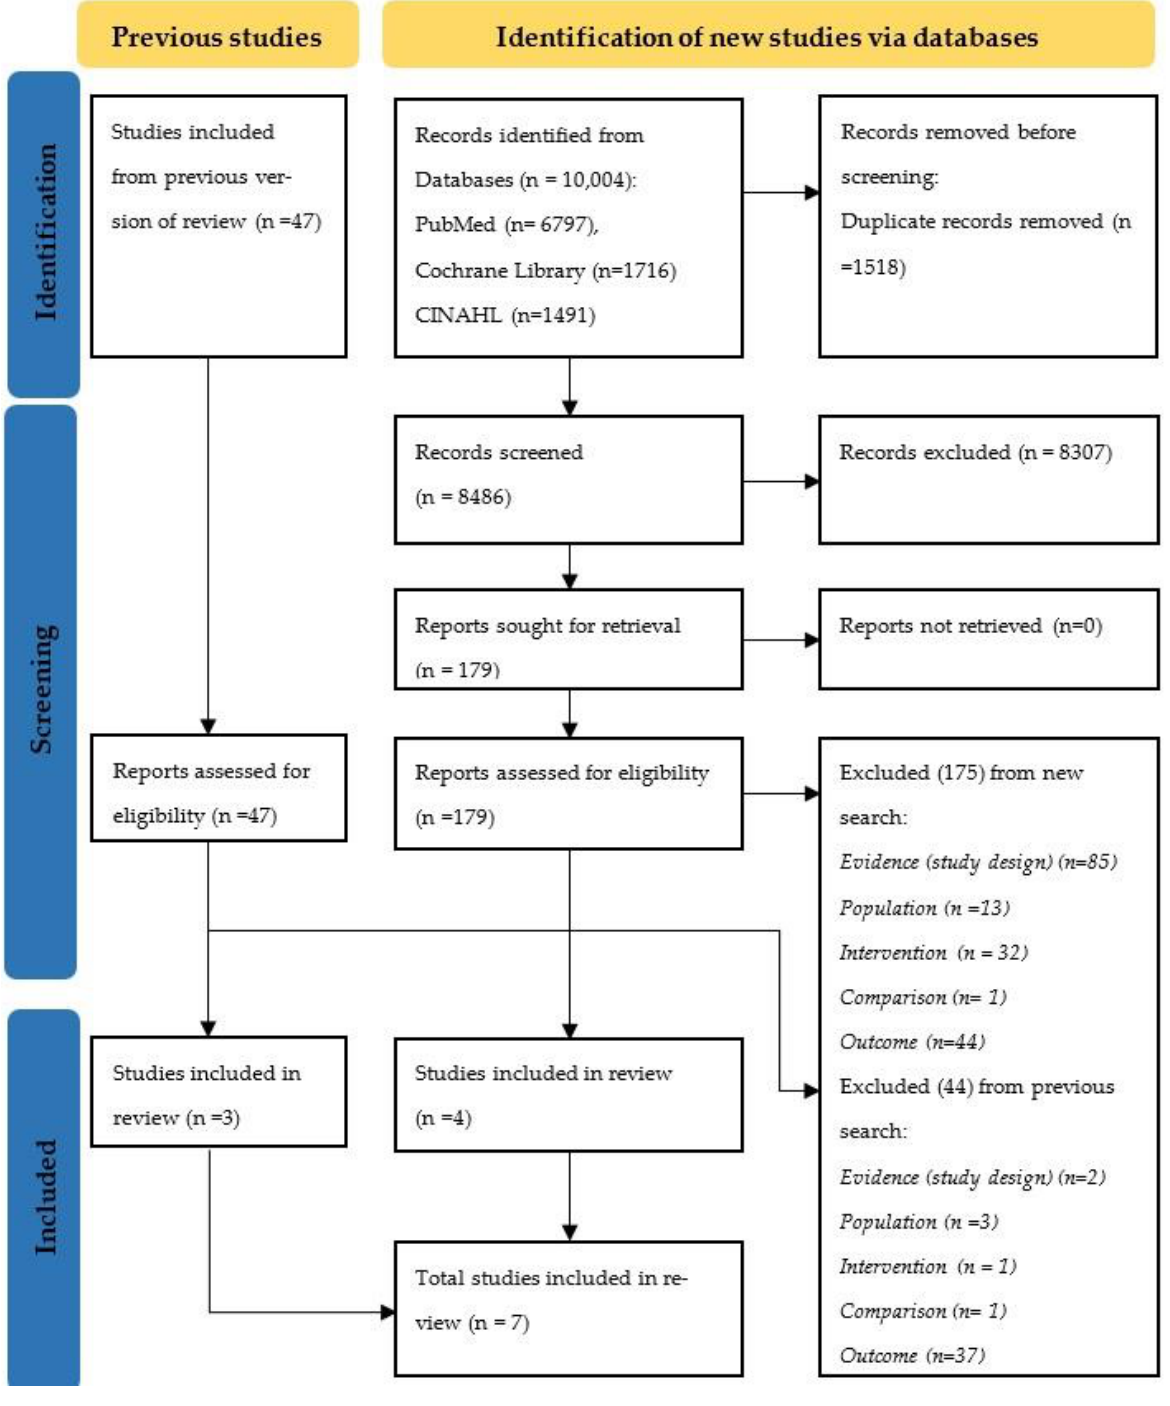
Figure 1. PRISMA flow diagram.